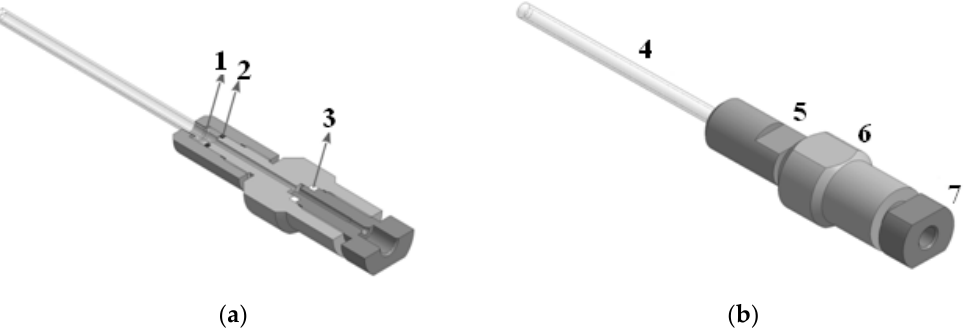
Figure 2. ( a ) High-pressure NMR cell (cross section): 1 is a capillary inlet seal (Teflon, Chemours, Wilmington, DE, USA), 2 is an ampoule seal (MVQ Silicones GmbH, Weinheim, Germany), 3 is a compensating gasket (Caprolon—polyamide, Shik Polymers, Moscow, Russia) ( b ) High-pressure NMR cell (full view): 4 is a high-pressure tube (synthetic single crystal sapphire Al 2 O 3 ), 5 is a tube holder (D16T, Metatorg, Ivanovo, Russia), 6 is a input port (D16T, Metatorg, Ivanovo, Russia), 7 is a capillary inlet high-pressure (D16T, Metatorg, Ivanovo,